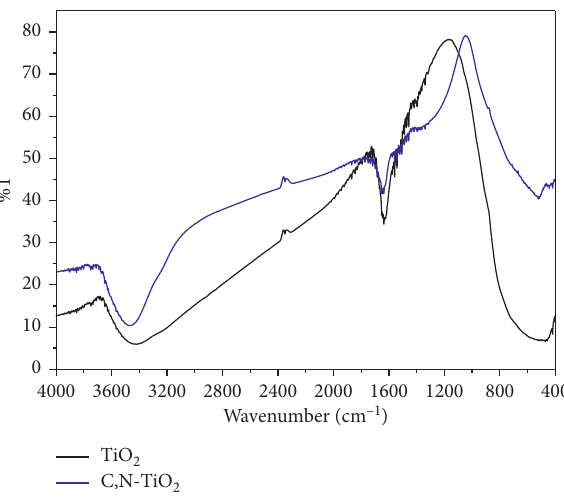
Figure 5: IR spectra of TiO 2 (a) and C, N-TiO 2 (b).